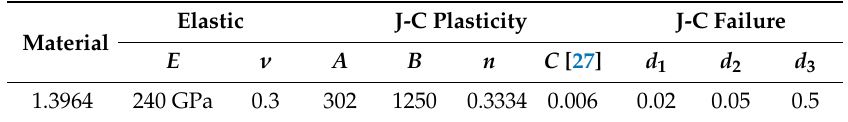
Table 3. Material constants for 1.3964 steel.